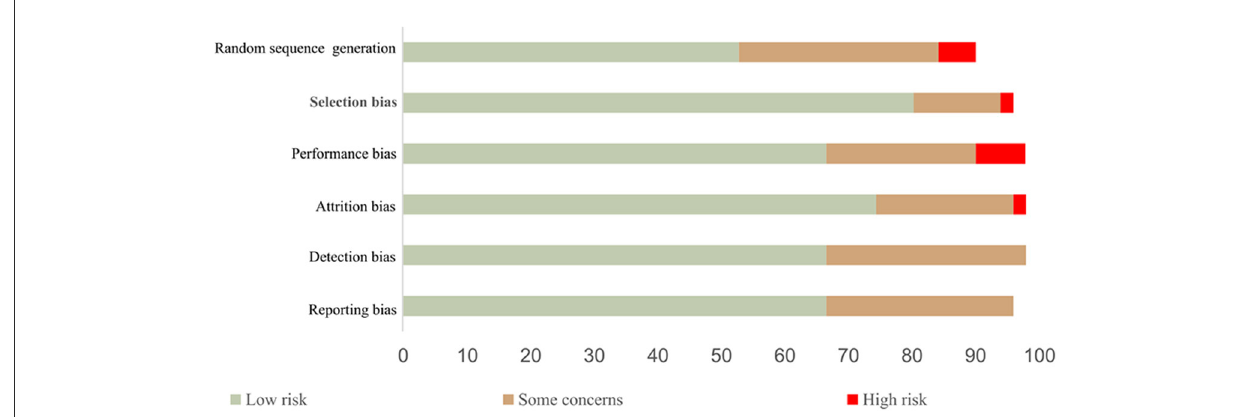
FIGURE5 Risk of bias assessment using the Cochrane Collaboration tool.